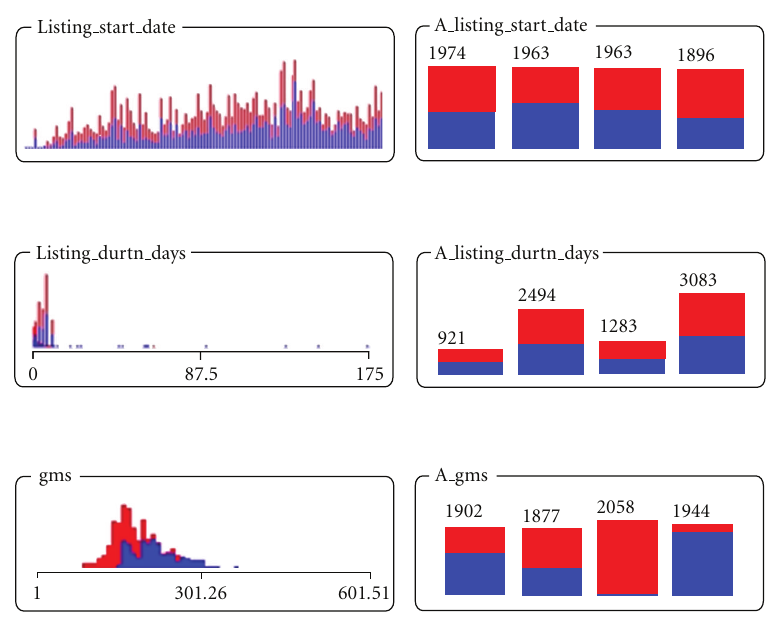
Figure 7: Snapshots of aggregated attributes (high, MedH, MedL,